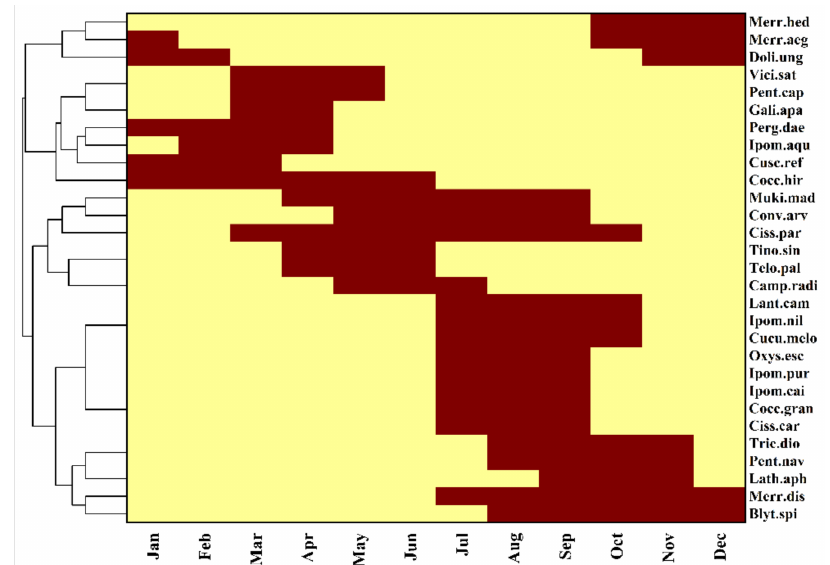
Figure 2. Heat map showing cluster dendrogram based on flowering response in a different month. Dark color indicates flowering, while light color indicates nonflowering stage. The letters on the right side of figure indicate the species codes while those on the lower side indicate the month. Full species names are mentioned in Table 1.